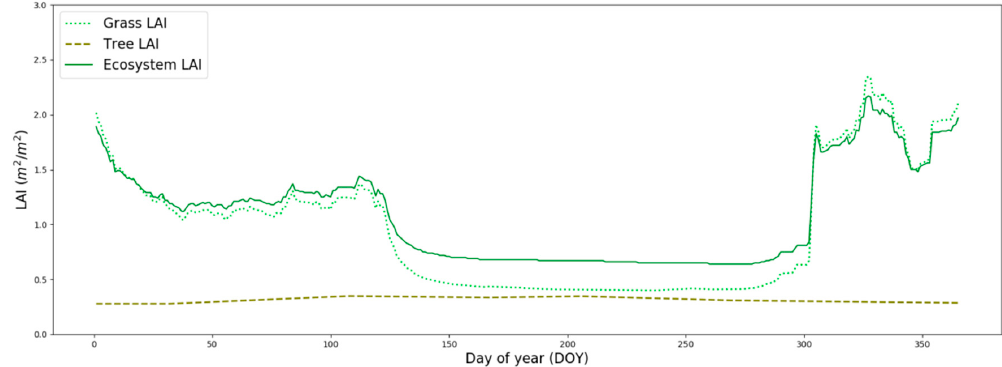
Figure A1. Empirical model between MODIS (MCD43A4) NDVI and in ‐ situ destructive grass LAI measurements developed for Majadas experimental site.